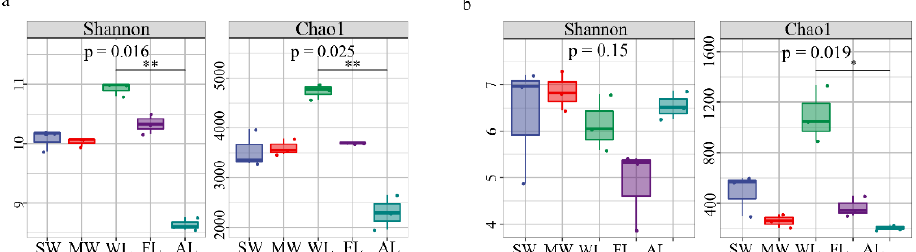
Figure 2. Diversity of soil microbial communities. ( a ) Bacterial and ( b ) fungal community α -diversity index in different land-use types. SW, swamp wetland; MW, meadow wetland; WL, woodland; FL, farmland; AL, alkaline land. * correlation significant at 0.05 level. ** correlation significant at 0.01 level.